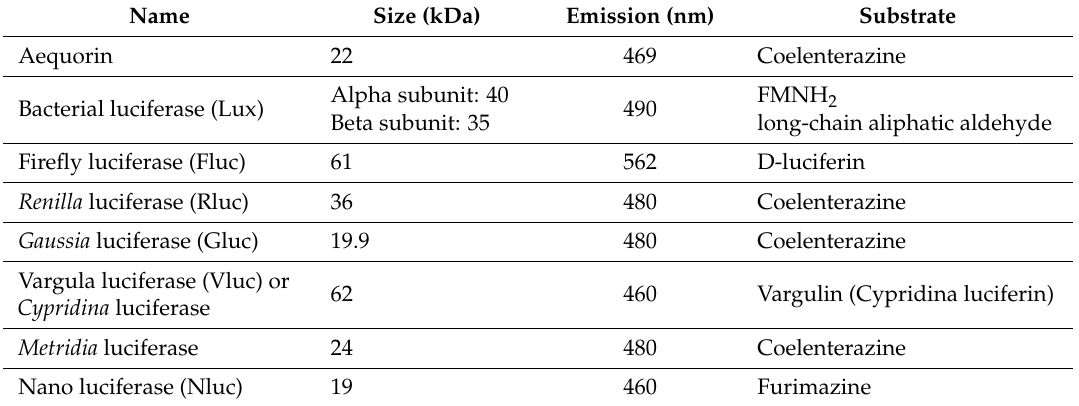
Table 1. Summary of Bioluminescent